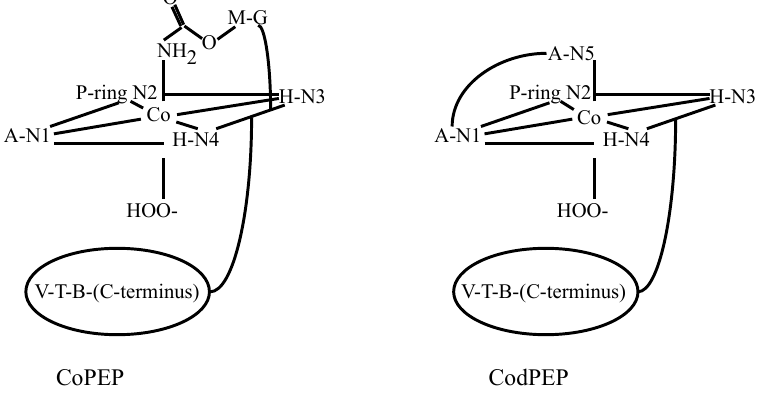
Figure 7. Coordination of scheme of Co(III) in HOO-CoPEP and HOO-CodPEP